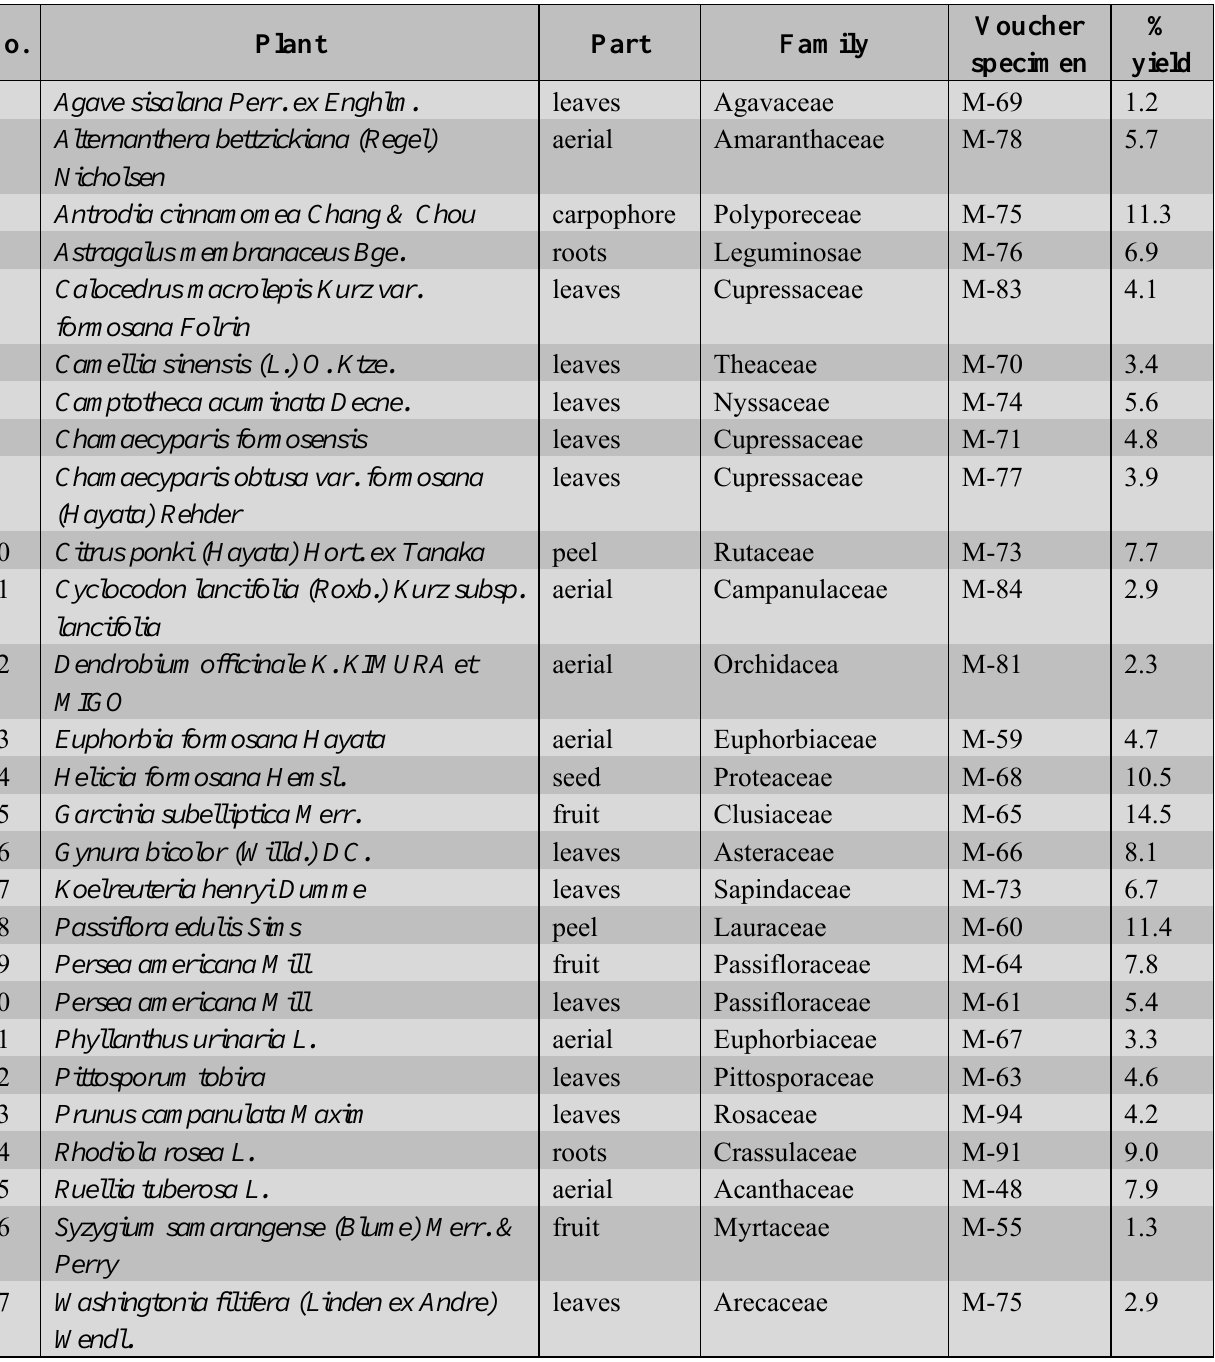
Table 1. Yields of 27 acetone plant